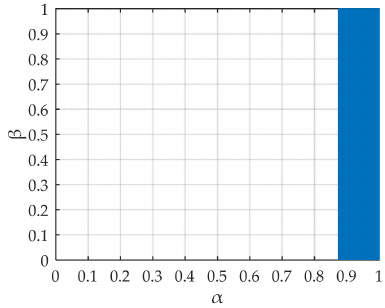
Figure 3. The operating area of the fractional-order flyback converter.